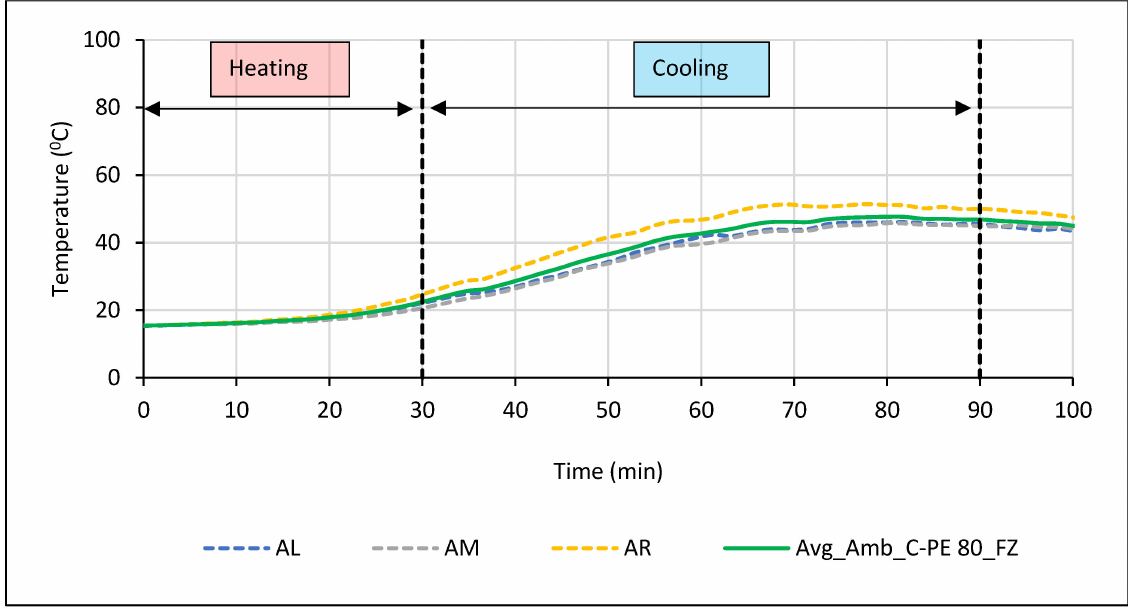
Figure 25. Ambient side surface time–temperature curves of C-PE 80 block from the bushfire